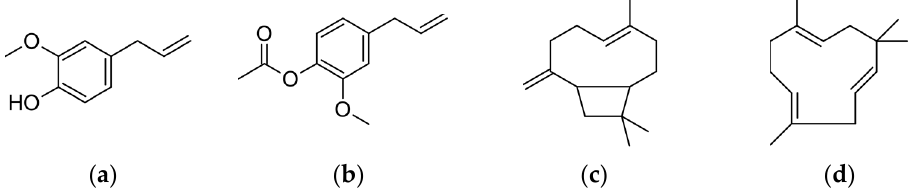
Figure 1. Structures of the four main compounds of clove extract (obtained by scCO 2 ): ( a ) eugenol, ( b ) eugenyl acetate, ( c ) β -caryophyllene, and ( d ) α -humulene.